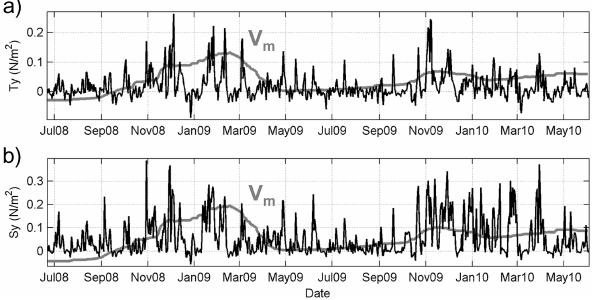
Figure 10. Time series of the daily averaged (a) alongshore wind stress ( T y , black) and (b) alongshore wave stress ( S y , black). The grey lines represent the behaviour of the bar migration rate V m that has been rescaled with the above variables.